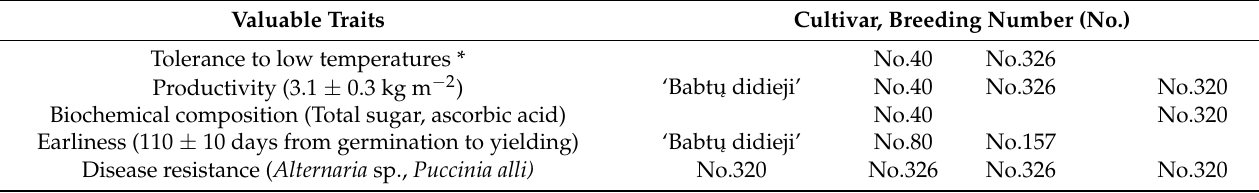
Table 6. Parental material from onion national and adapted genetic